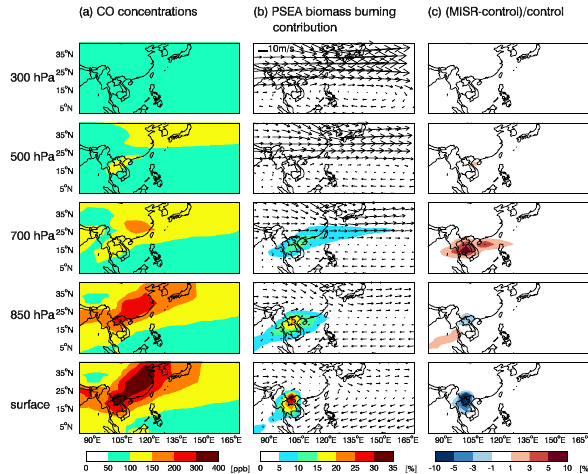
Fig. 4. (a) Monthly mean CO concentrations and (b) the fractions contributed by biomass burning from PSEA at five different alti- tudes during March 2001 in the control simulation. Arrows indi- cate the monthly mean wind. (c) The percent changes of simulated monthly mean CO concentrations in the MISR-constrained simula- tion relative to the control